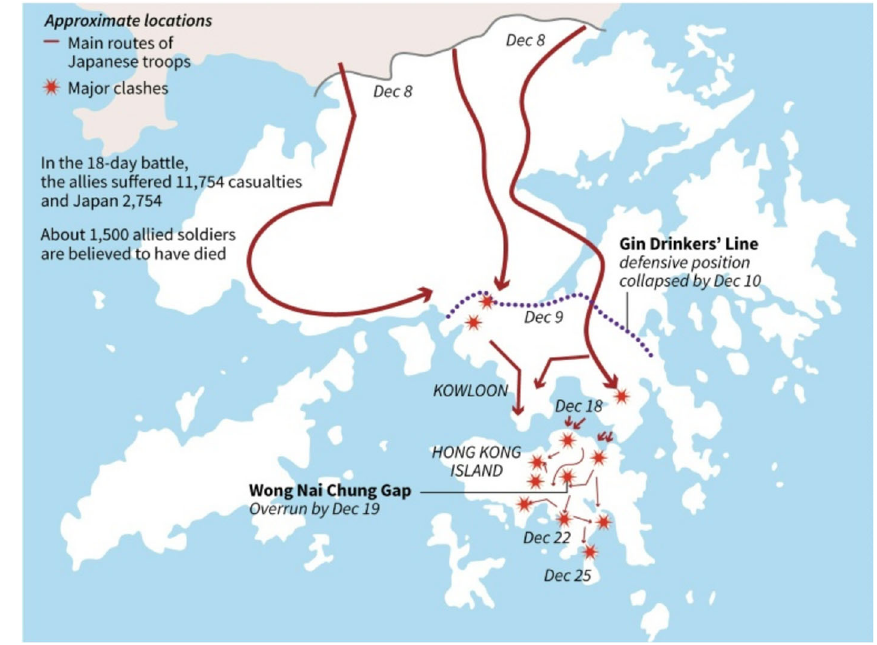
Fig. 2 The Japanese invasion in Hong Kong and the location of the Gin Drinkers ’ Line (Source: Monro